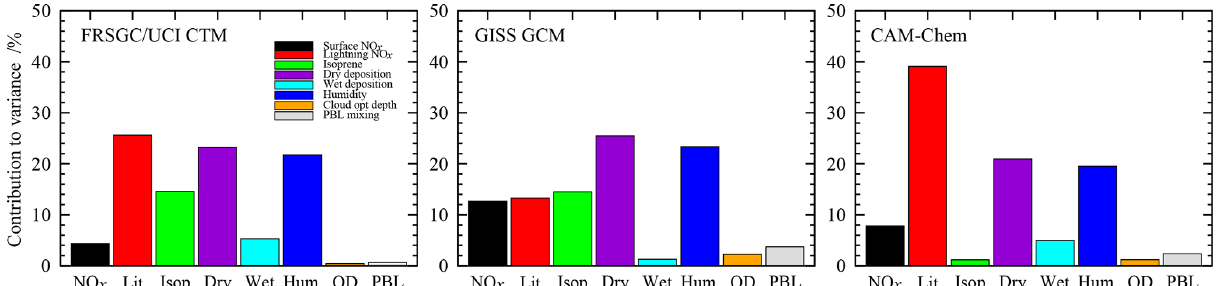
Figure 3. Contributions of each variable to the total variance in the simulated tropospheric O 3 burden in each model.